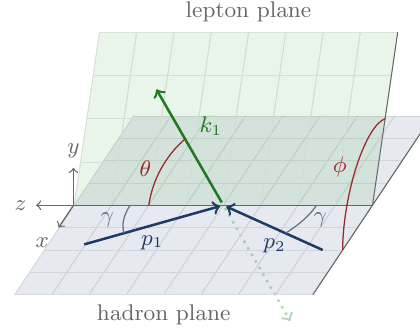
Figure 1 . Schematic diagram illustrating the kinematic con(cid:12)guration for the process.